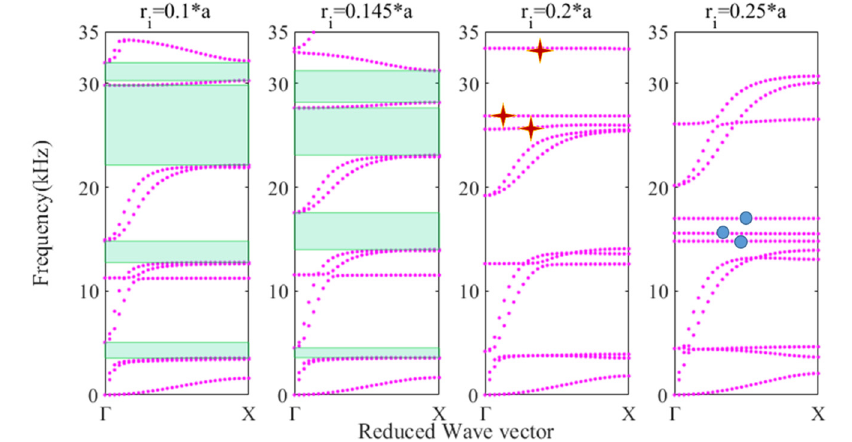
Figure 6. The influence of hollow radius on the dispersion curve of the HPFC.